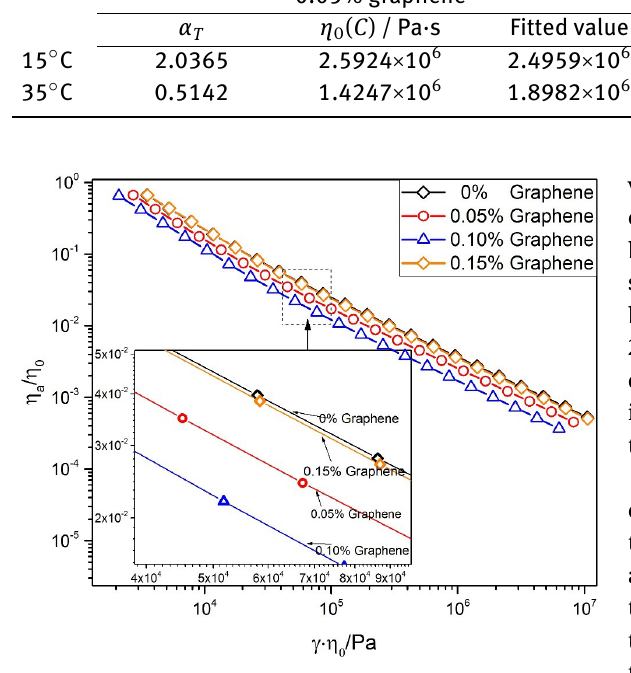
Figure 9: Master curves of different graphene concentration at reference temperature is 25 ∘